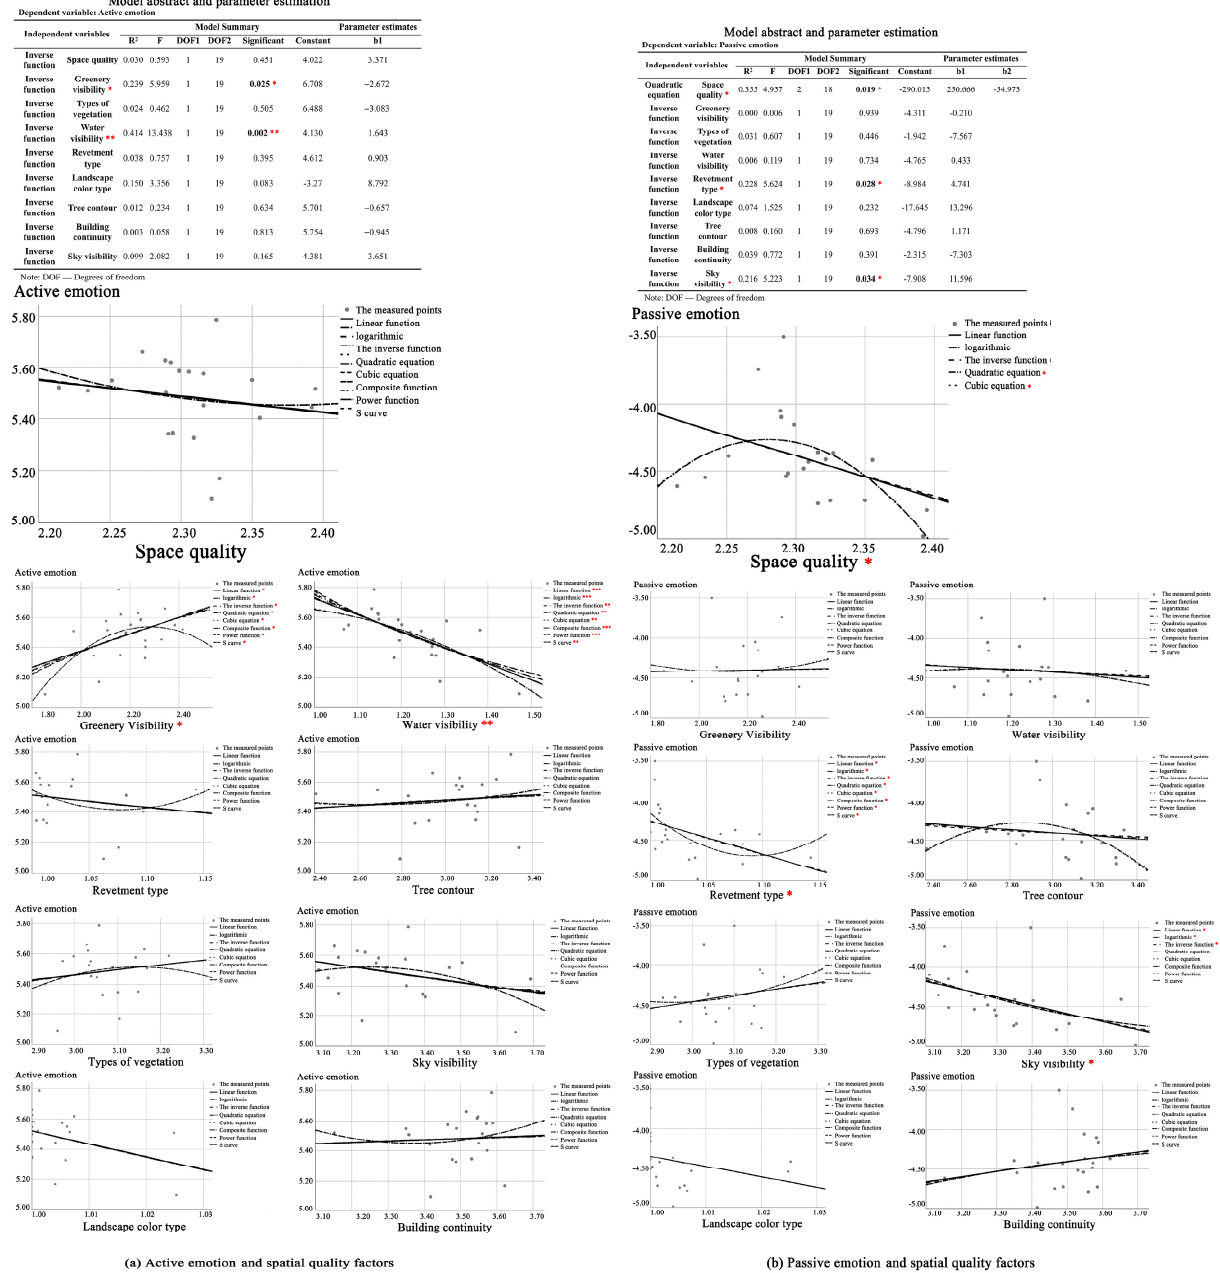
Figure A2. Curve estimation results (*** p < 0.001, ** p < 0.01, * p < 0.05).